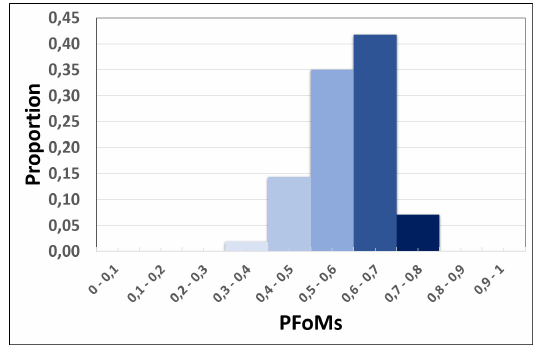
Figure 4. Histogram of proportions of PFoMs obtained with the Adaptive Canny Method for Large objects, from 13 to 21 pixels, both included